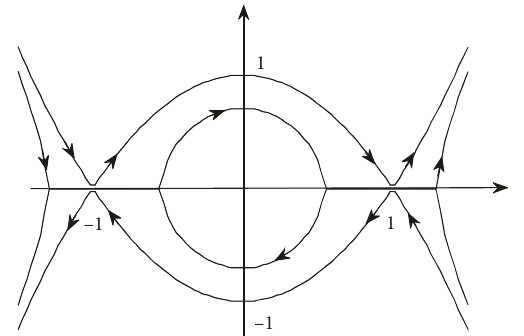
Figure 14: Phase portraits of rotor bearing system of grinding motorized spindle.